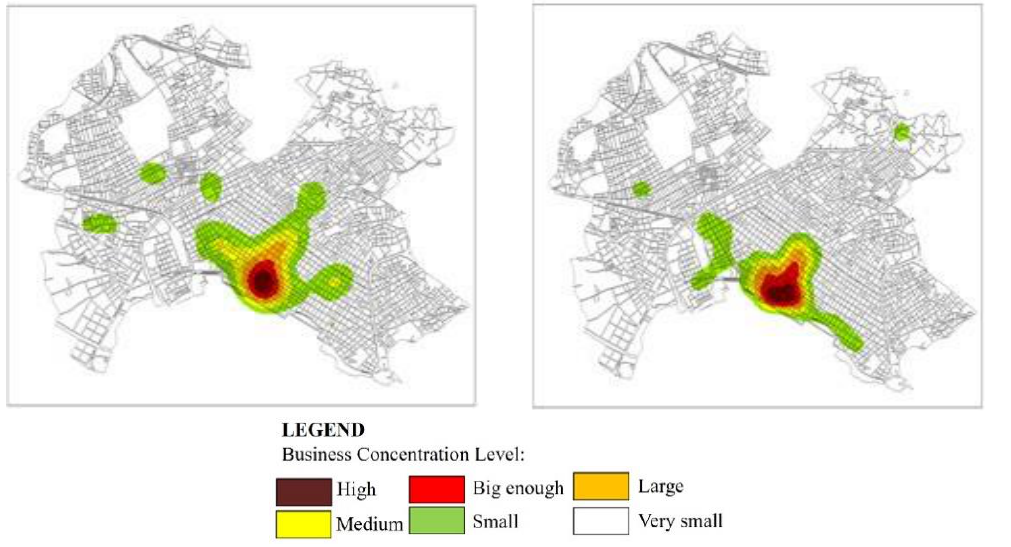
Figure 5. Kernel density for the years 2008–2018 for the companies that opened in the respective years, Source: Chamber of Magnesia, Own processing.